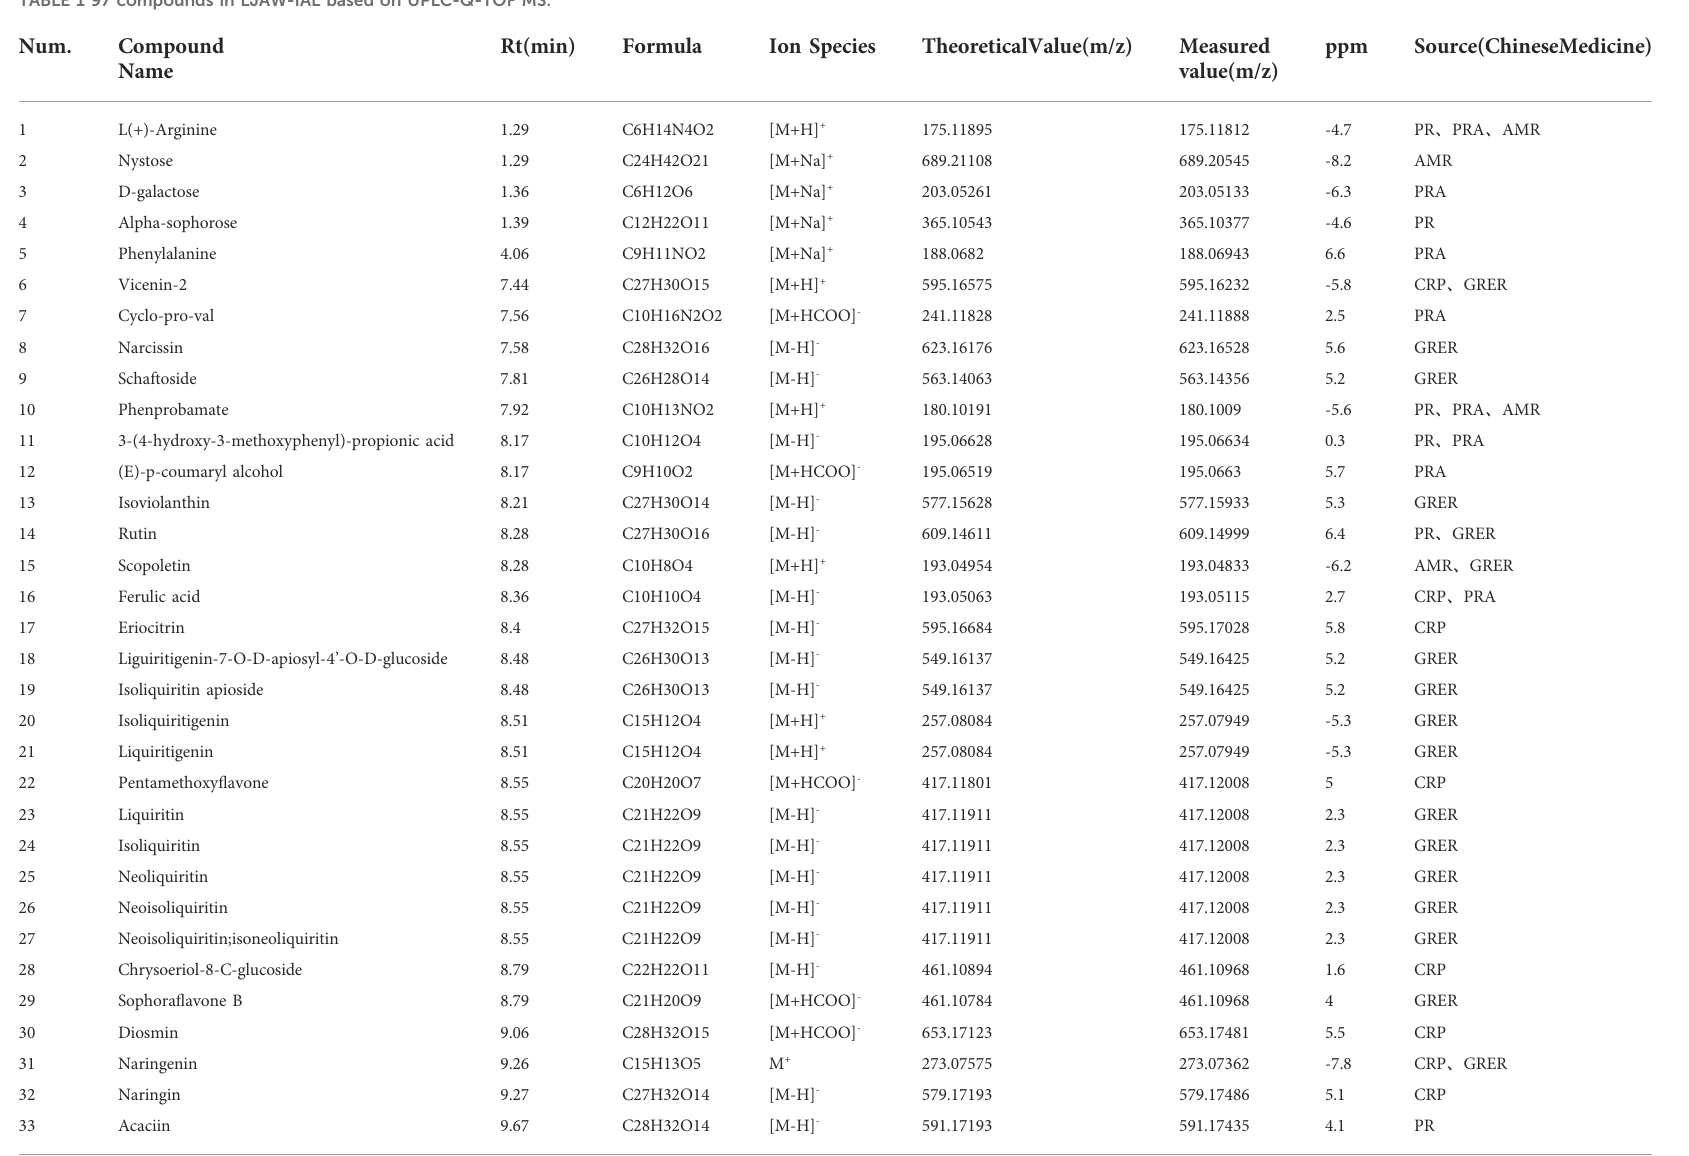
TABLE 1 97 compounds in LJAW-IAL based on UPLC-Q-TOF MS.